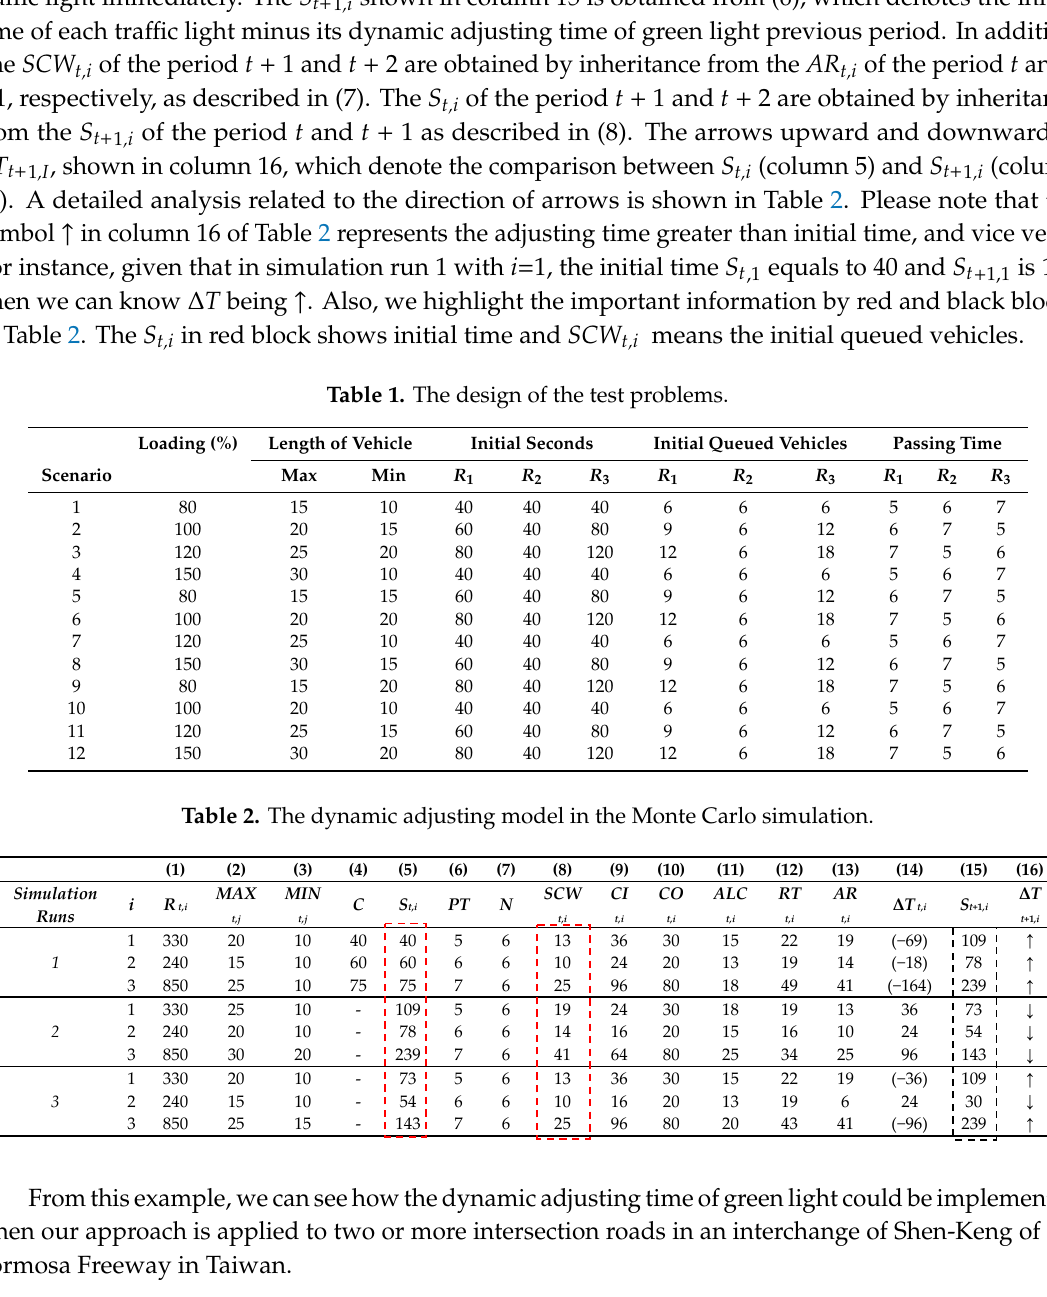
Table 1. The design of the test problems.